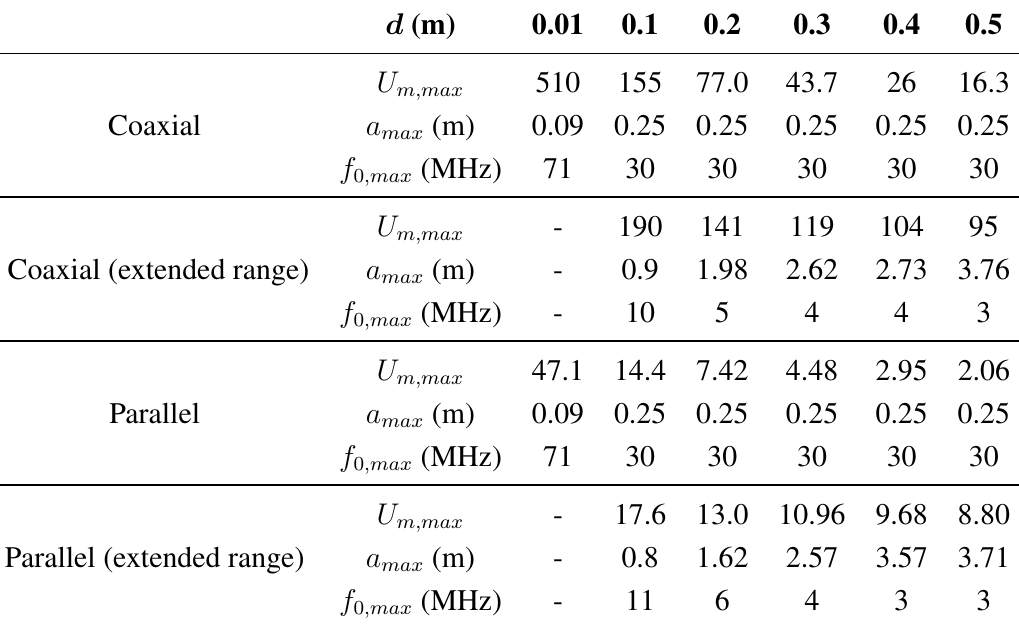
, for the parameter sweeps of the loop m,max